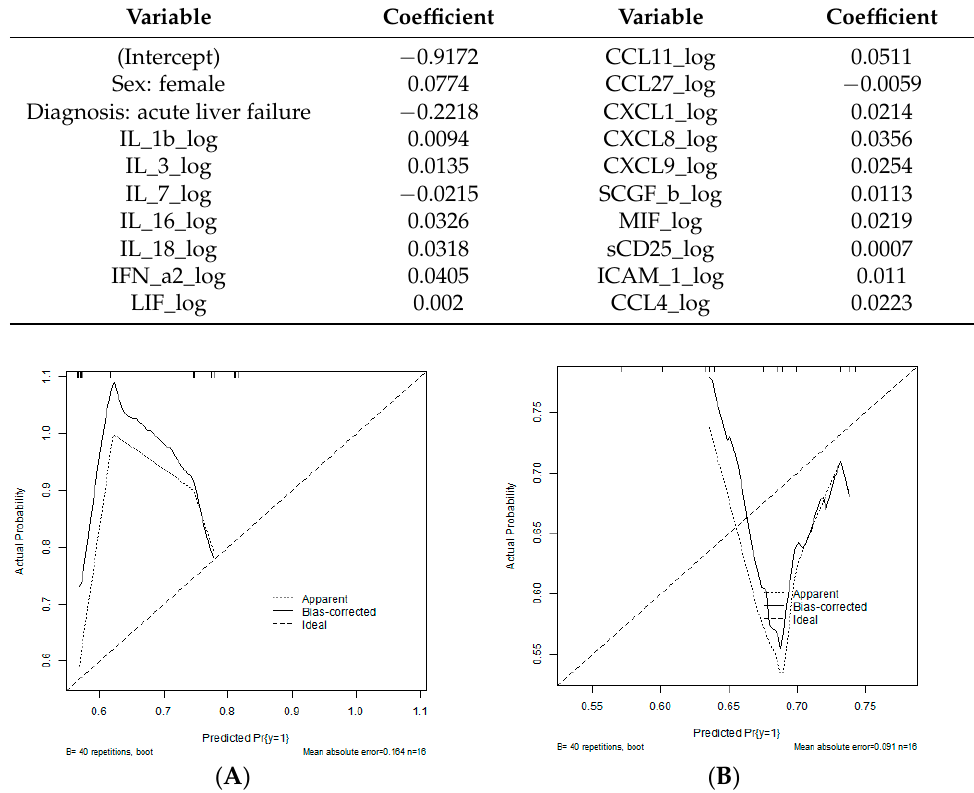
Figure 3. Calibration curves for the best fitting models. ( A ) Gradient boosting machine. ( B ) Elastic net regression. Table 5. Cytokines included into a diagnostic model derived from elastic net regression.